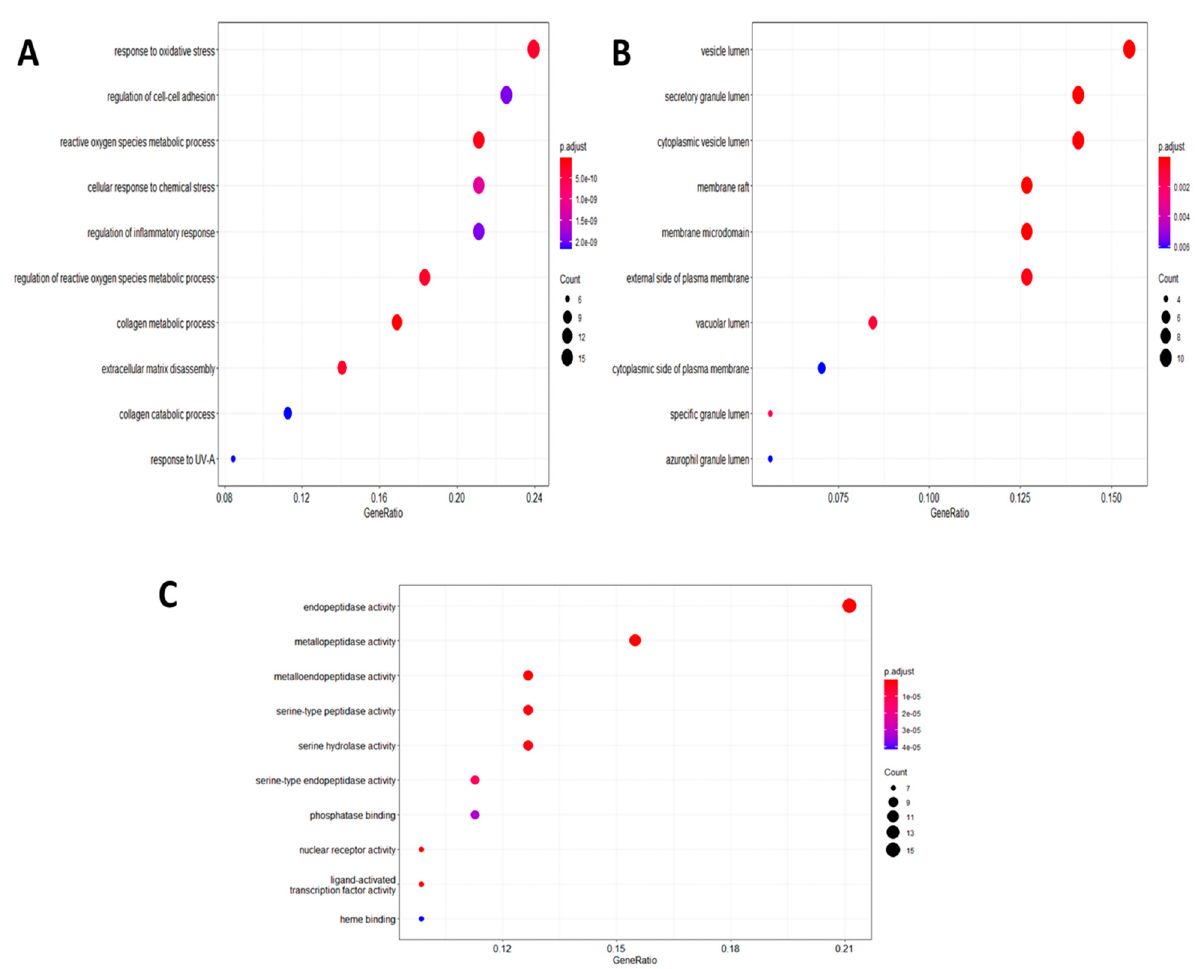
Figure 7. Bubble map of GO and KEGG pathway analysis ( A ) Biological process of GO analysis; ( B ) cellular components of GO analysis; ( C ) Molecular function of GO analysis.